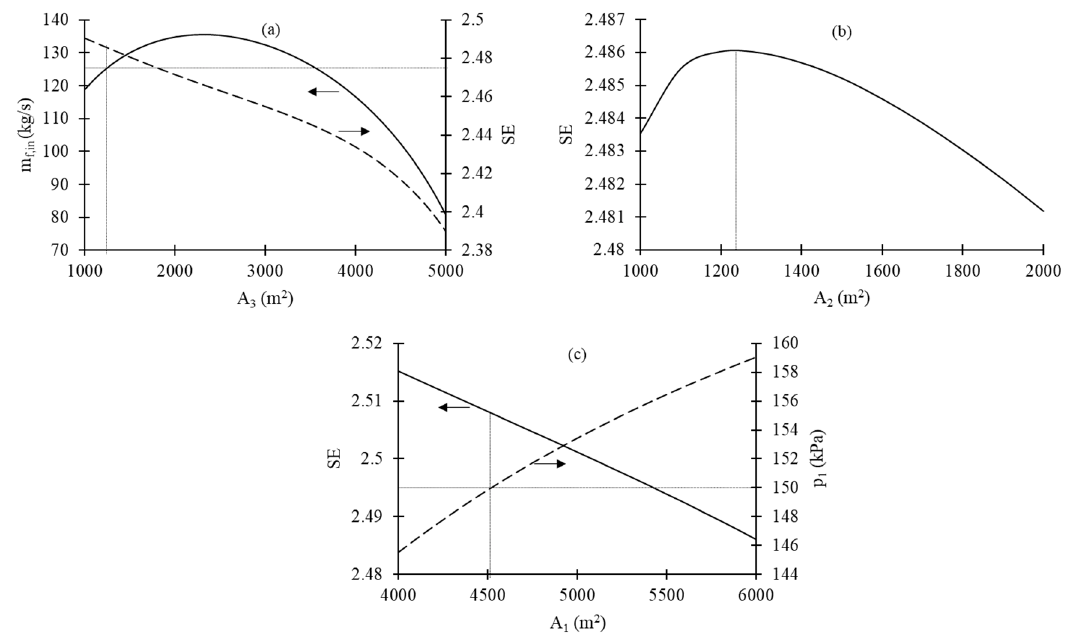
Figure 4. Procedure for determining the optimum distribution of evaporator area in the conventional evaporation process driven by extracted steam at a pressure ( p 0 ) of 200 kPa: ( a ) finding third ‐ effect area ( A 3 ) corresponding to the inlet juice mass flow rate ( m f , in ) of 125 kg/s and the maximum steam economy ( SE ) corresponding to first ‐ effect area ( A 1 ) = 6000 m 2 , and second ‐ effect area ( A 2 ) = 1200 m 2 ; ( b ) finding A 2 that maximizes SE corresponding to A 1 = 6000 m 2 ; and ( c ) finding A 1 corresponding to the first ‐ effect pressure ( p 1 ) of 150 kPa.